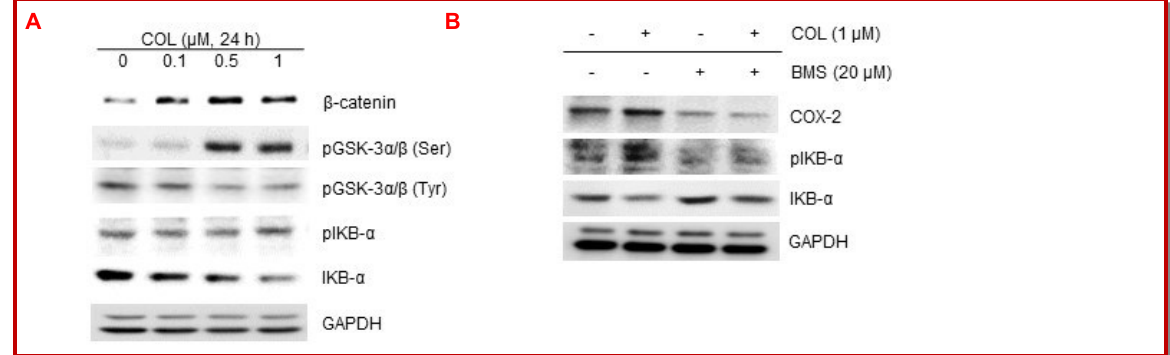
Figure 4: Colchicine cause regulating β -catenin expression via phosphorylation of GSK-3 αβ and modulating NF- κ B pathway. (A and B) Chondrocytes were either left untreated or subjected to a variety of colchicine treatments for 24 hours (A) or for the given amounts of time (1 μ M colchicine) (B). Western blot analysis was used to determine the expression levels of β -catenin, pGSK-3 αβ (Ser9/21), pGSK-3 αβ ( Tyr216/279), pI κ B α, I κ B α, and glyceraldehyde-3-phosphate dehydrogenase (GAPDH). GAPDH was used as a loading control. The findings of an average experiment or the mean values plus standard deviation from at least four different experiments are represented by the